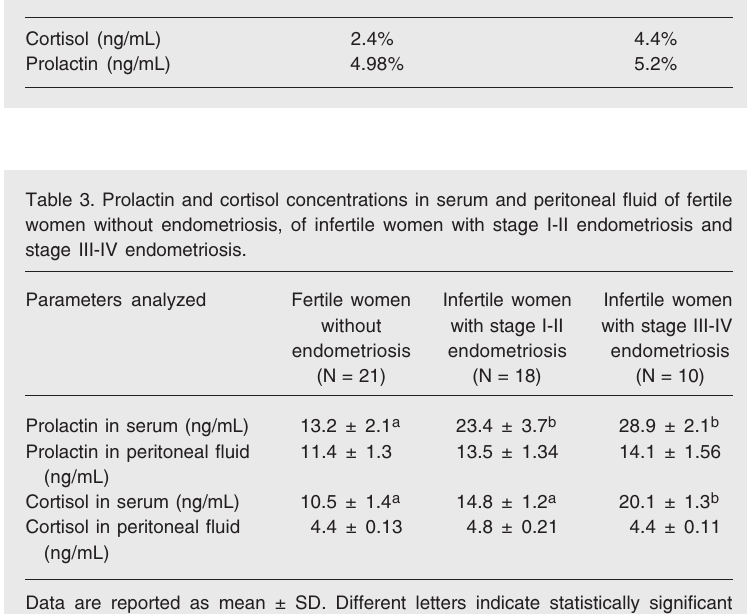
Table 2. Margin of error based on the number of patients included in each group for the collection of follicular fluid. Parameters analyzed